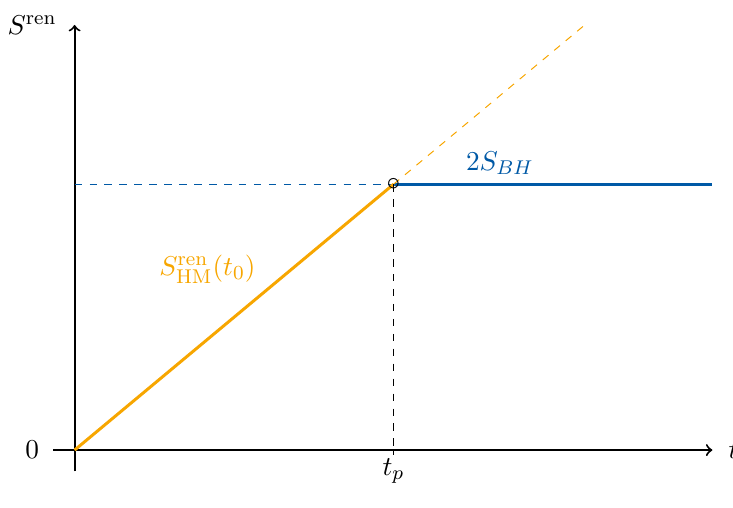
Figure 1 . A sketch of the renormalized entanglement entropy of Hawking radiation emitted from an eternal AdS black hole into a bath, as a function of time t . The orange curve S ren d entropy of the Hartman-Maldacena surface, while the blue curve represents the maximum amount of information that can be emitted. The phase transition must occur by t = t more entropic black holes. This Page curve is only for t ≥ 0 , but we can also extend it to negative times. By time-reversal symmetry, the Page curve is actually symmetric about t = 0